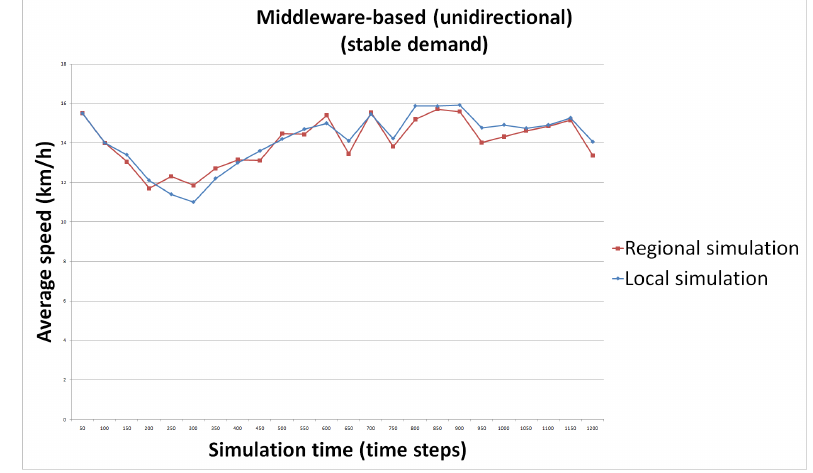
Figure 9. Average speeds for Scenario S3.